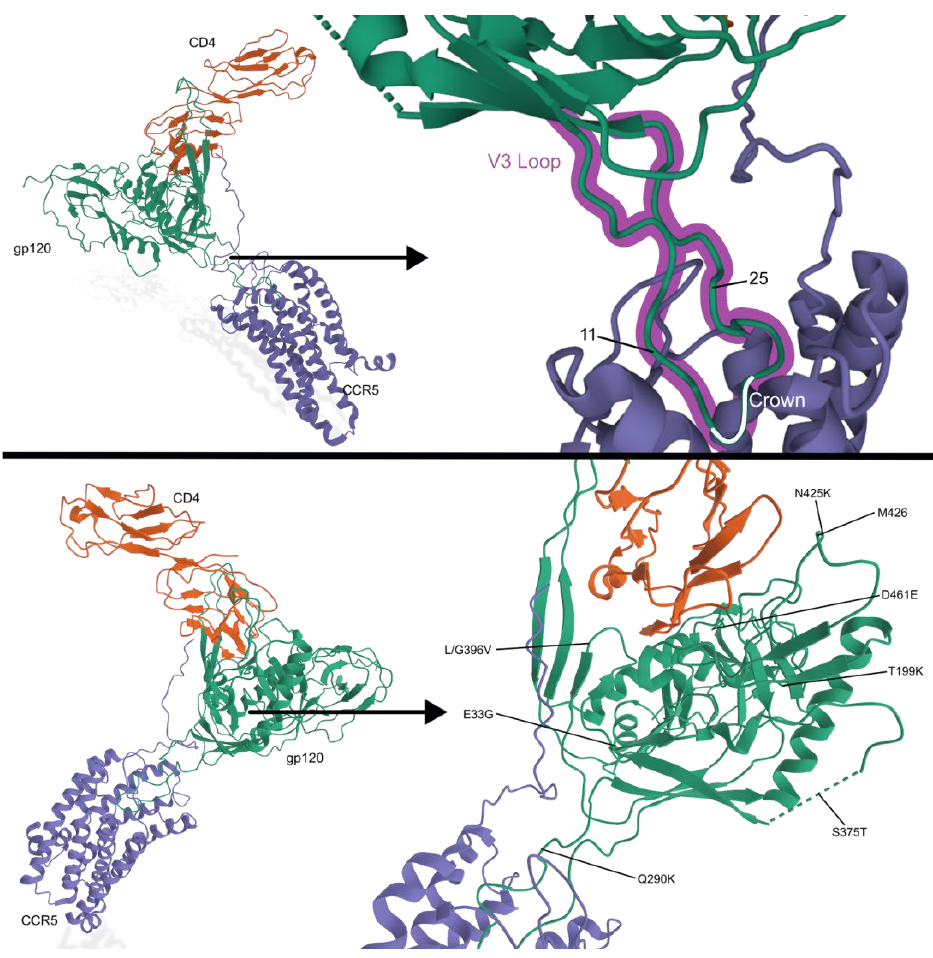
Figure 6. HIV receptor interactions. gp120 (green) interacts with both CD4 (orange) and CCR5 (purple). In the top half, the V3 loop is highlighted in magenta. The 11/25 rule, a common guideline to determine tropism, is associated with the locations noted in the V3 loop. The V3 loop’s crown is a crucial location for binding and is highlighted in white. In the lower half, the C4 region of gp120 is shown with its treatment-associated mutations. Based on PDB 6MEO [45 – 47,96].